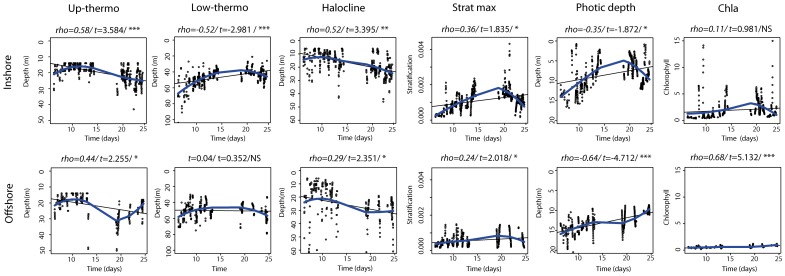
Temporal correlations of the physical variables.Analyses were done according to inshore and offshore ecological domains. Scatter plots include a linear fit (black solid line) and loess smoothing (blue solid line) to illustrate the sign of the correlation.